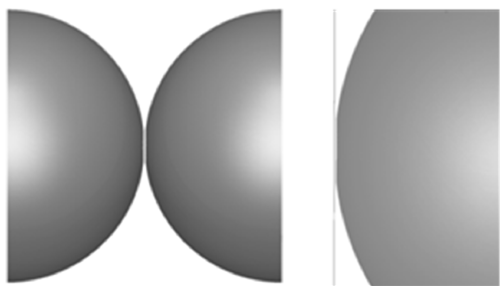
Figure 2. Treatment of contact points showing close-up views of caps approaches, for both particle-particle and particle-wall cases.